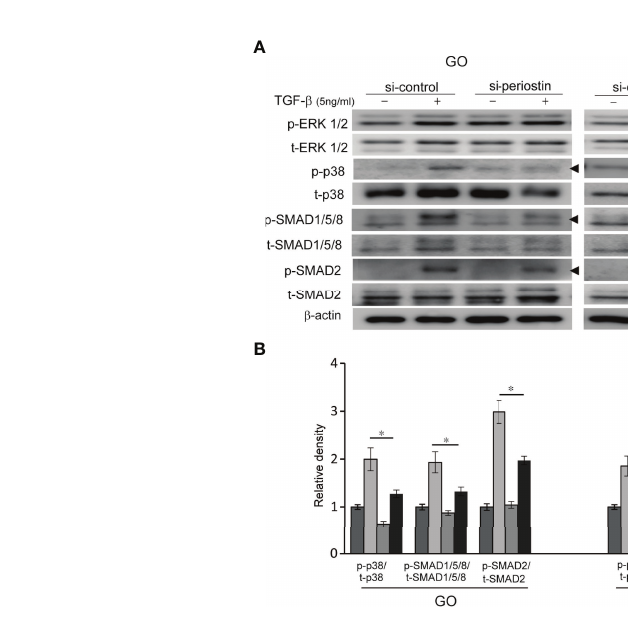
FIGURE 4 | Effect of silencing periostin on the activation of signaling molecules in response to TGF- b treatment. (A) Orbital fi broblasts from GO patients (n=3) and normal patients (n=3) were treated with 5 ng/ml TGF- b for 15 minutes after cells were transfected with control siRNA or periostin-targeting siRNA for 48 h. (B) Knockdown of periostin suppressed TGF- b induced phosphorylation of p38, SMAD1/5/8 and SMAD 2 protein in GO orbital fi broblasts. Phosphorylation of SMAD1/5/8 protein was inhibited by silencing periostin in normal orbital fi broblast. The representative gel images are also shown, and the results from orbital fi broblasts are presented as the mean density ratio ± SD, normalized to the level of b -actin in the same sample. ( *p < 0.05 vs. TGF- b -stimulated cells).